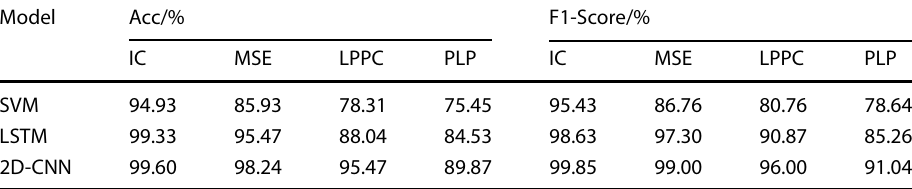
Table 4 Comparison of Accuracy and F1-Score of each model in